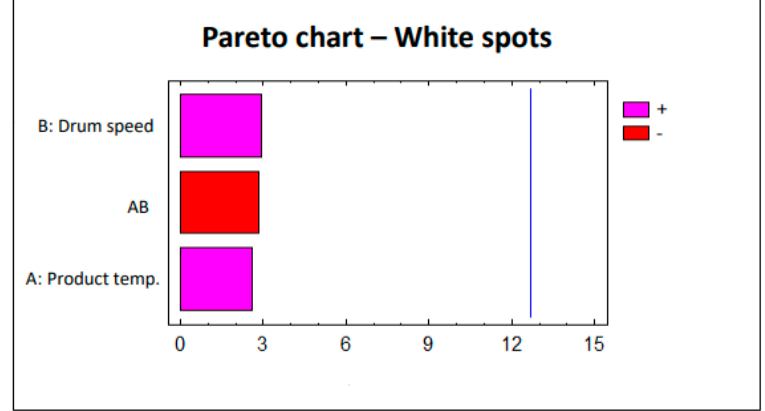
Figure 2. Study 1 Pareto chart—Erosion.